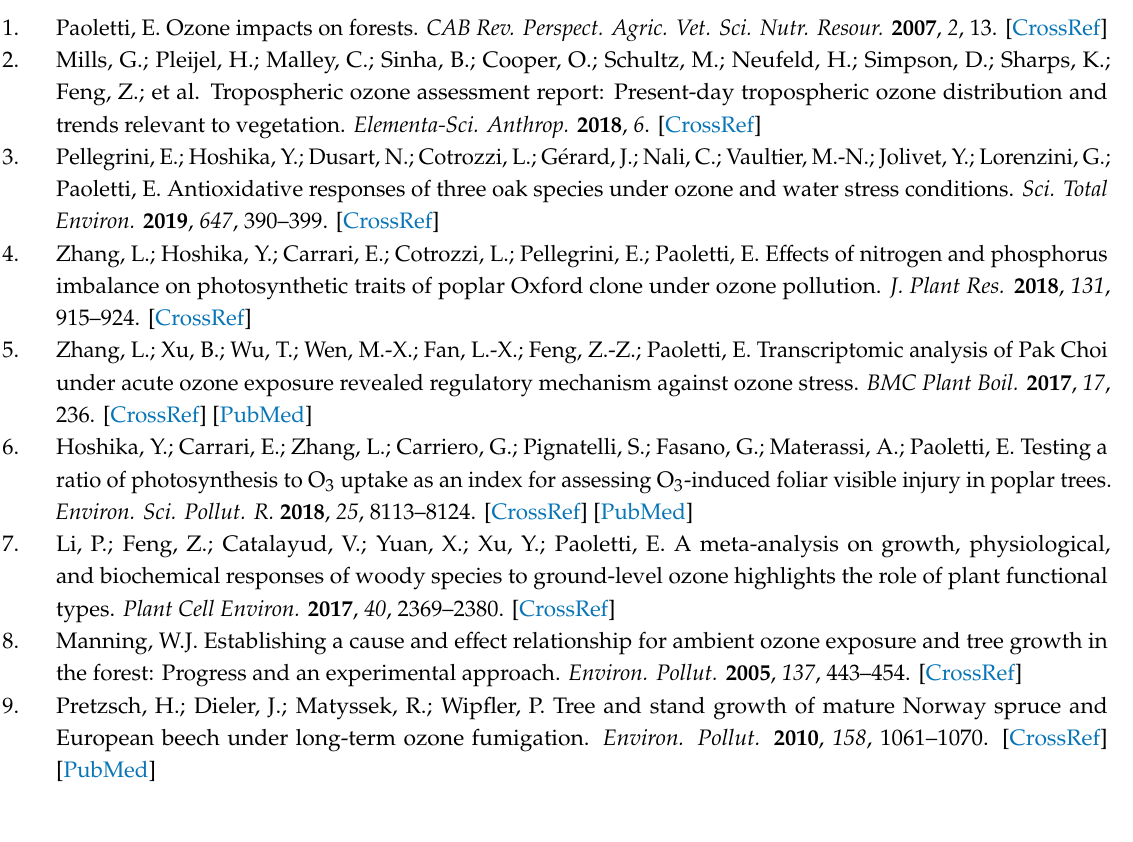
Figure S1: Time series of hourly stem radius variation (a, ∆ R ± SD) and instantaneous stem water deficit (b, ∆ W ± SD) during ten days of high evaporative demand and M24 > 40 ppb in WAT and EDU trees (N = 5 trees). i Data of stem radius were set to 0 before the analyses. ∆ W i was extracted by de-trending the daily time series of ∆ R using a piecewise linear